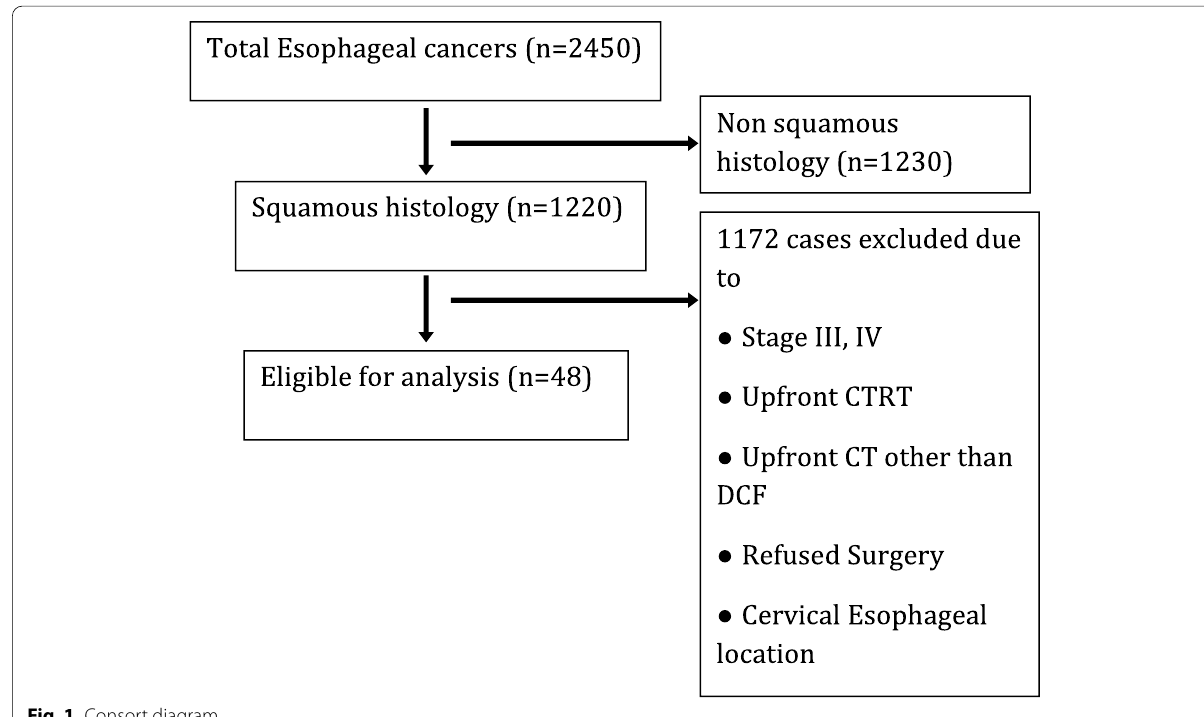
Fig. 1 Consort diagram